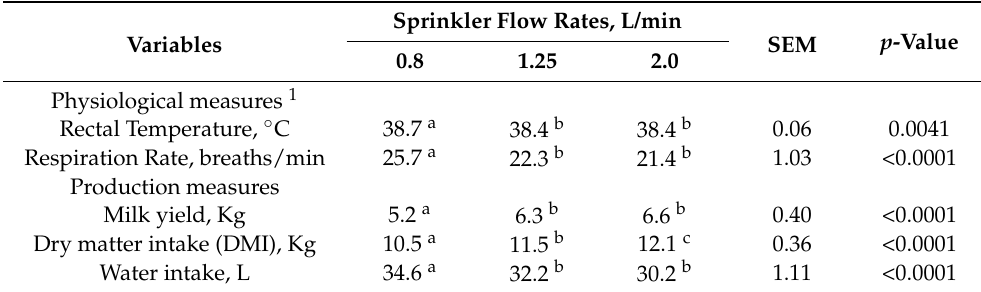
Table 4. Effect of sprinkler flow rate on production and physiological responses of Nili Ravi buffaloes ( n = 18) during